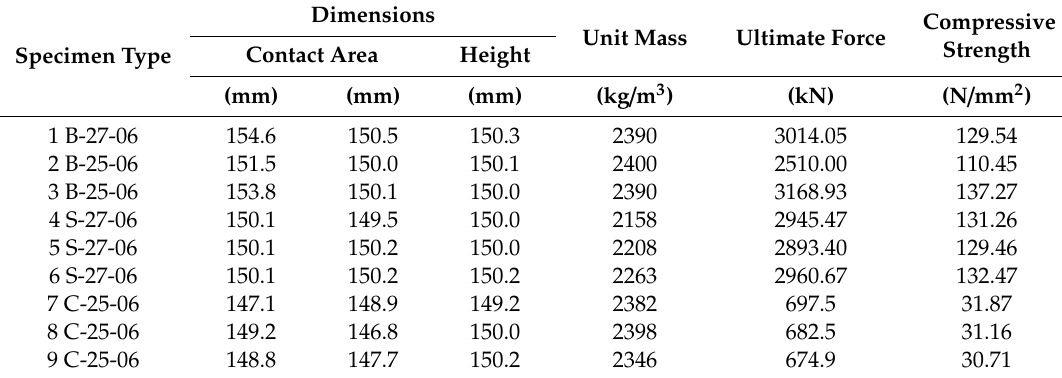
Table 8. The result of concrete compressive strength measurement.